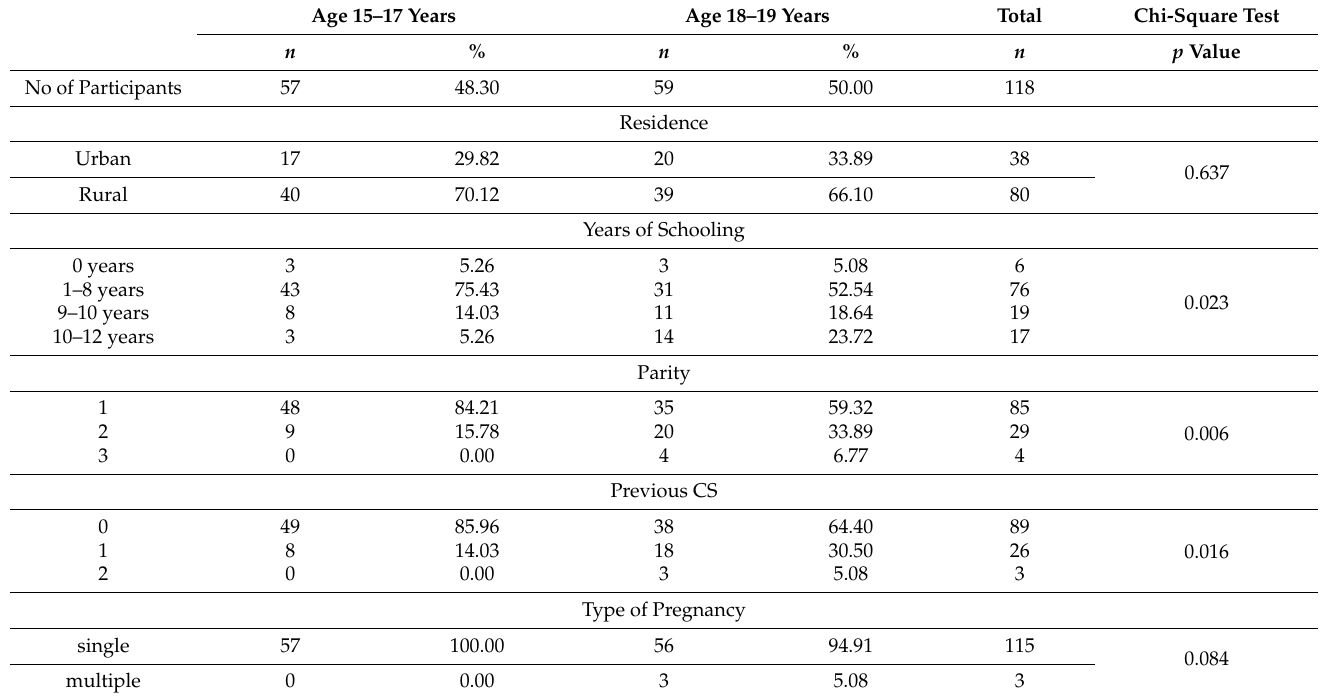
Table 2. Characteristics of adolescents by age